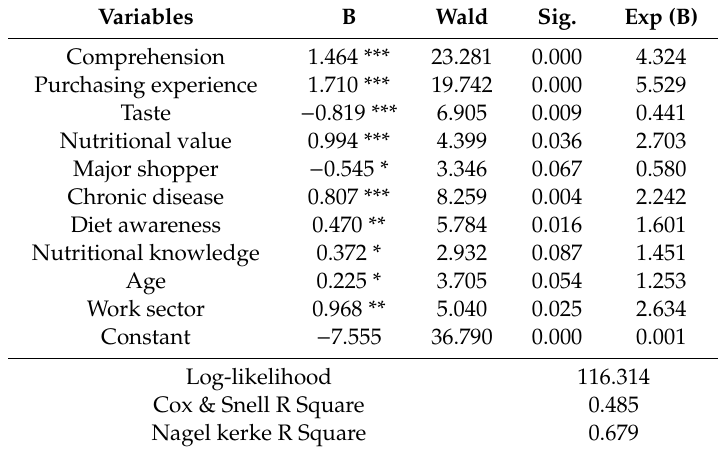
Table 3. Regression Analysis Results of Factors Related to Consumer Nutrition Label Reading.